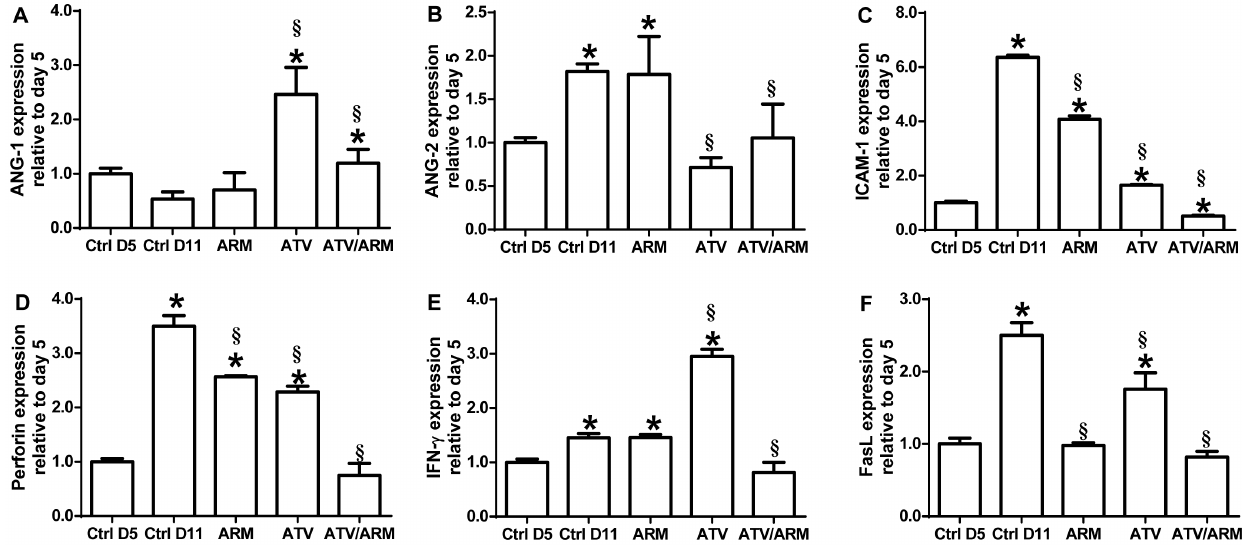
Figure 4. Assessment of transcriptome associated with endothelium activation and blood-brain barrier integrity. mRNA expression of angiopoietin-1 (A), angiopoietin-2 (B), ICAM-1 (C), perforin (D), IFN- c (E), and FasL (F) in whole brain homogenates of control, ARM, ATV, and ATV/ ARM-treated P. berghei -infected mice ( n =5 per group). Expression, measured by real-time PCR on day 11 post-infection, is relative to the mean expression value in control mice day 5 post-infection brain samples and normalized with HPRT values. Treatment with ATV or ATV/ARM decreases endothelium activation and improves blood-brain barrier integrity. Columns and bars represent means 6 standard error. Mean expression values were determined to be significantly different using one-way ANOVA with Holm-Sidak post-tests method for all pairwise multiple comparison. A p value of , 0.05 was considered significant. Asterisks (*) denote statistically significant change compared with ctrl D5 and section sign ( 1 ) denote statistically significant change compared with ctrl D11. Note the different scales used in each graph. Ctrl=control; D=day; ARM=artemether; ATV=atorvastatin.